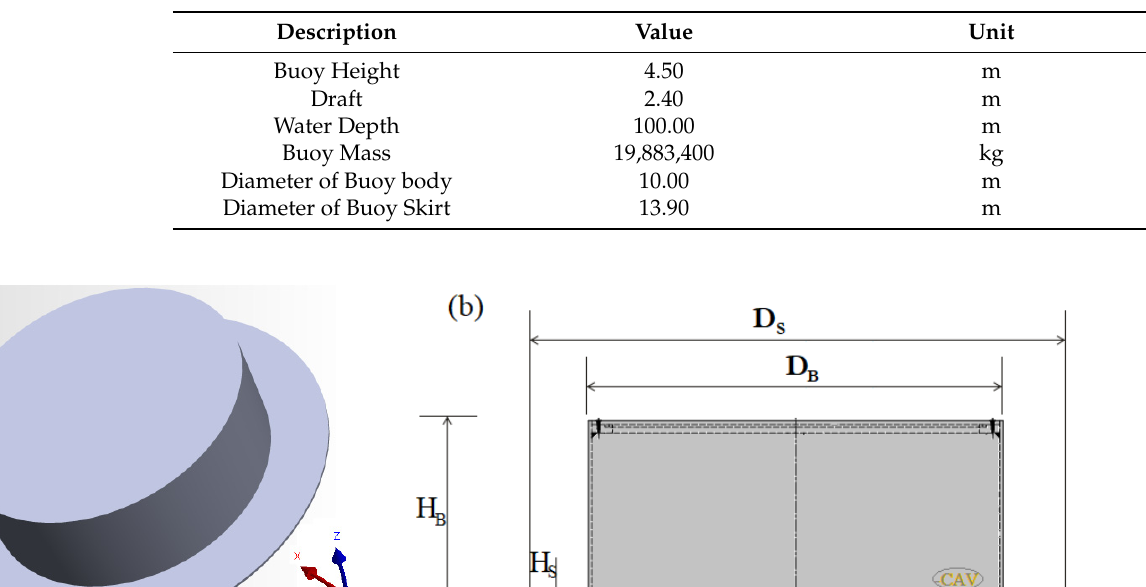
Table 1. Parameters of the buoy.